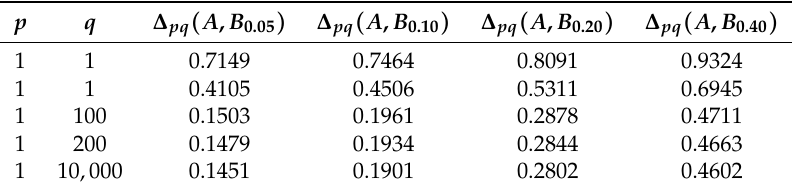
Figure 13. The black horizontal segment is the set A from Equation (14), and the blue piecewise map is the respective approximation given by the set B δ from Equation (15) for two values of δ and ε = 0.10. Table 4. ∆ p , q results between the sets A and B δ in Equations (14) and (15) for ε = 0.10 and some parameter values of p , q , and δ .